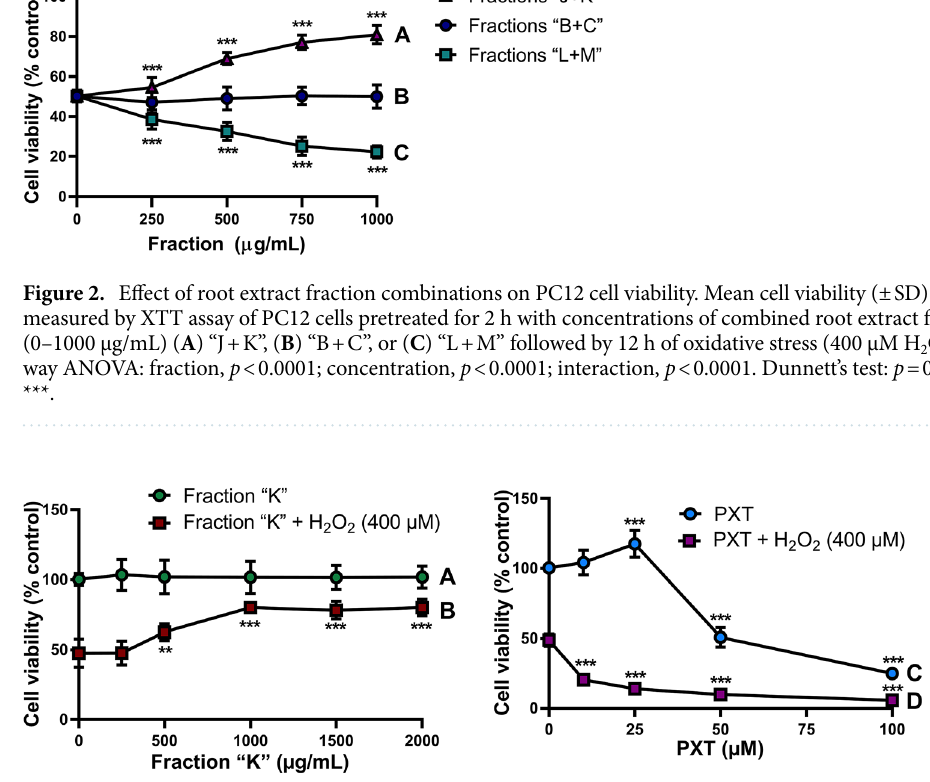
Figure 3. Comparative effects of fraction “K” and PXT on cell viability. Mean cell viability (± SD) measured by XTT assay for ( A ) PC12 cells incubated with concentrations of fraction “K” (0–2000 μg/mL) for 14 h or ( B ) PC12 cells pretreated with concentrations of fraction “K” (0–2000 μg/mL) for 2 h followed by incubation for 12 h with H 2 O 2 (400 μM). Mean cell viability (± SD) measured by XTT assay for ( C ) PC12 cells incubated with concentrations of PXT (0–100 μM) for 14 h or ( D ) PC12 cells pretreated with concentrations PXT (0–100 μM) for 2 h followed by incubation for 12 h with H 2 O 2 (400 μM). Two-way ANOVA: ( A,B) Concentration, p < 0.0001; pretreatment, p < 0.0001; interaction, p < 0.0001. Sidak: all treatments, p < 0.0001; Dunnett’s test: ( B) 500 μg/mL, p = 0.0006; 1000–2000 μg/mL, p < 0.0001. ( C,D) Concentration, p < 0.0001; pretreatment, p < 0.0001; interaction, p < 0.0001. Sidak: all treatments, p < 0.0001; Dunnett’s test: ( C) 25–100 μM, p < 0.0001; ( D) all treatments, p < 0.0001. **, p = 0.0006; ***, p <